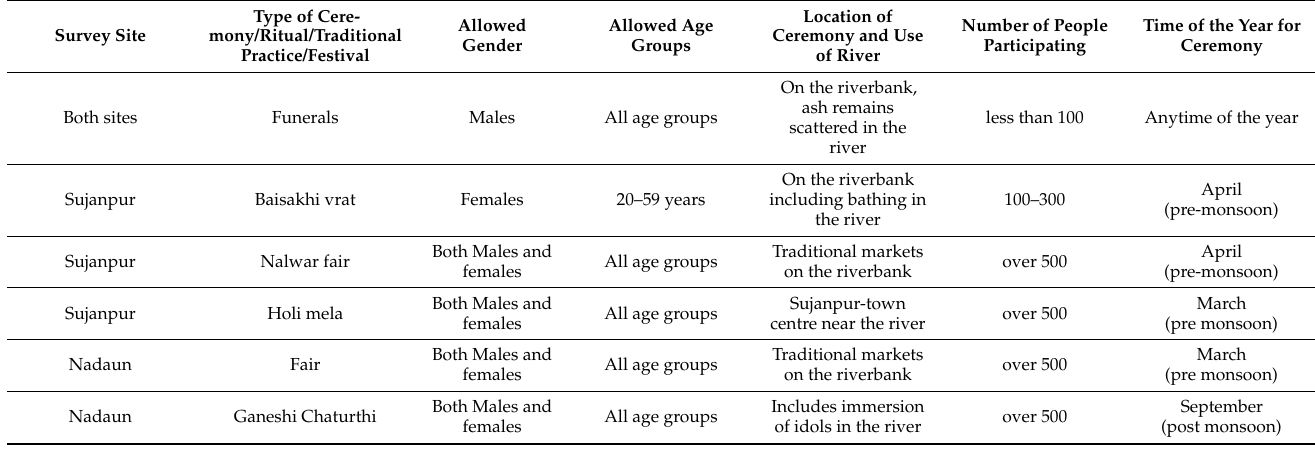
Table 2. Ceremonies/festivals conducted in the Beas River.